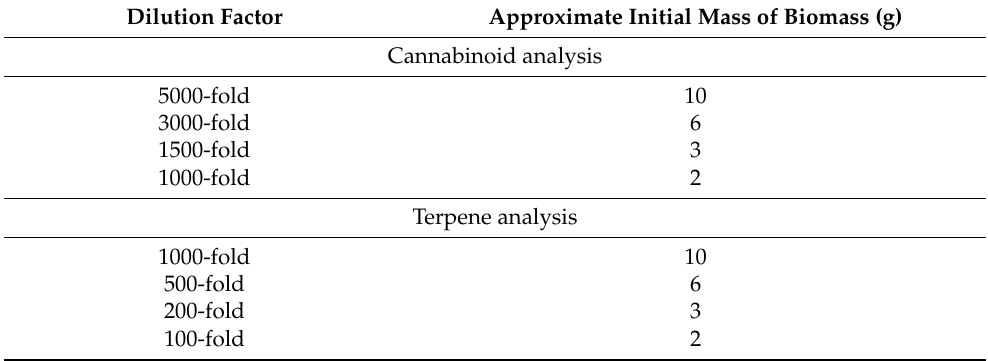
Table 5. Dilution factors used for cannabinoid and terpene analyses for the extracted sample biomass.